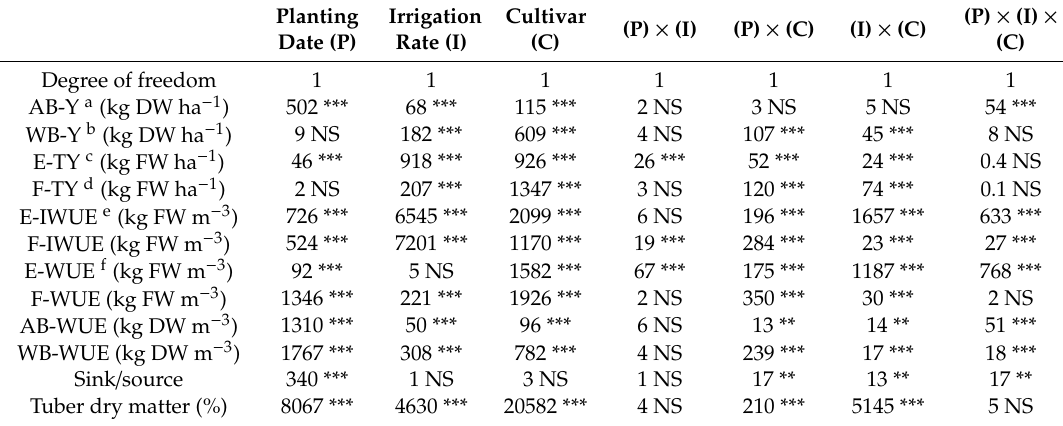
Table 2. F values resulting from analysis of variance for all studied